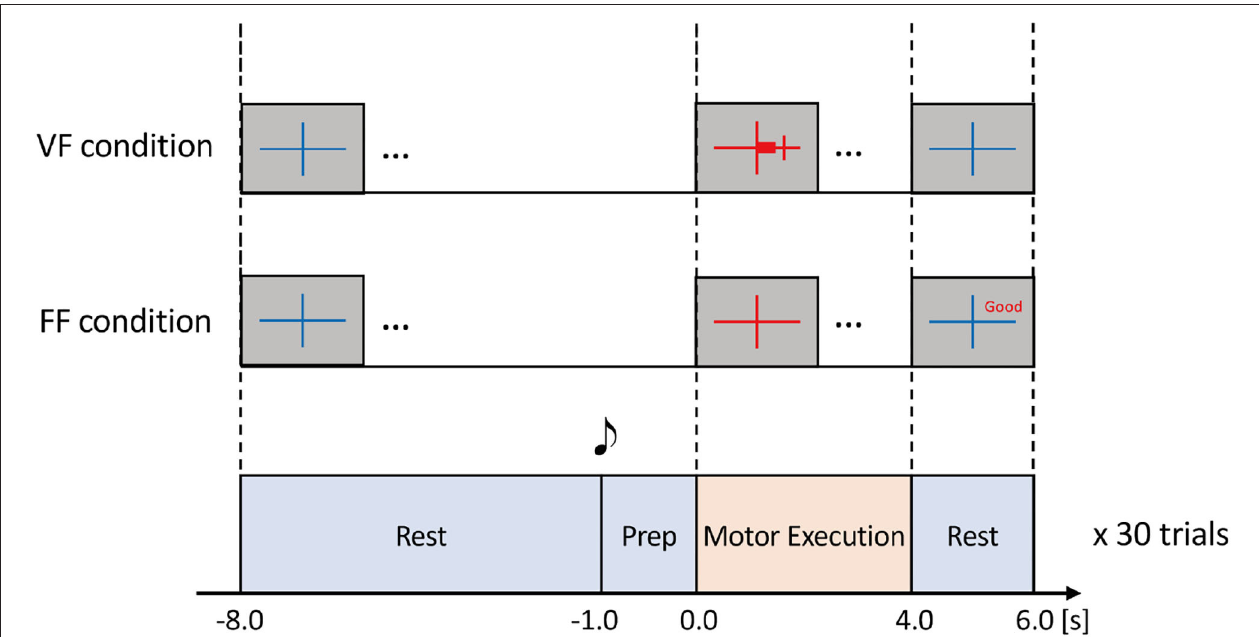
FIGURE 2 | Experimental task. The task comprised Rest, Prep, and Motor Execution periods. During the Rest period, participants were instructed to relax. 1.0 s before the Motor Execution period, a beep sound was played for notification. During the Motor Execution period, the participants were instructed to grasp their right hand and maintain the grasping force within a specified range chosen from 10, 25, or 40%MVF with visual feedback (VF) or a feedforward (FF) condition. In the VF condition, a red horizontal bar indicated the extent of grasping force in real-time. In the FF condition, no online feedback was provided, but the precision of grasping force (i.e., the extent of error) was shown after the Motor Execution period. Thus, there were six experimental conditions according to the combination of %MVF × the way of feedback. In each condition, the experimental task was repeated 30 times to obtain sufficient EEG